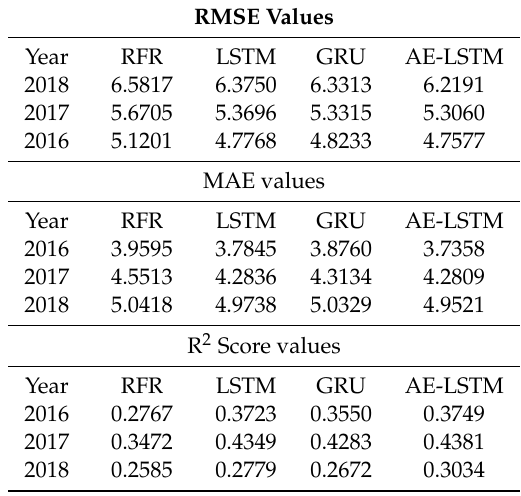
Table 2. RMSE, MAE and R 2 score values of solar radiation for di ff erent